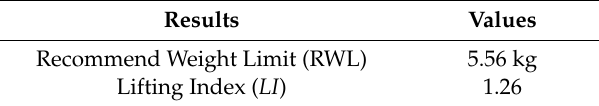
Figure 7. Example of lifting posture during hand harvesting. Table 4. NIOSH lifting equation results for lifting task show in Figure 7.